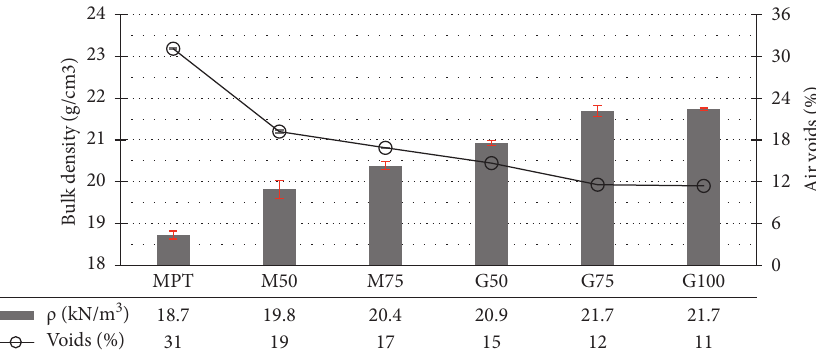
Figure 4: Bulk density and air voids depending on the type of compaction and compaction energy.